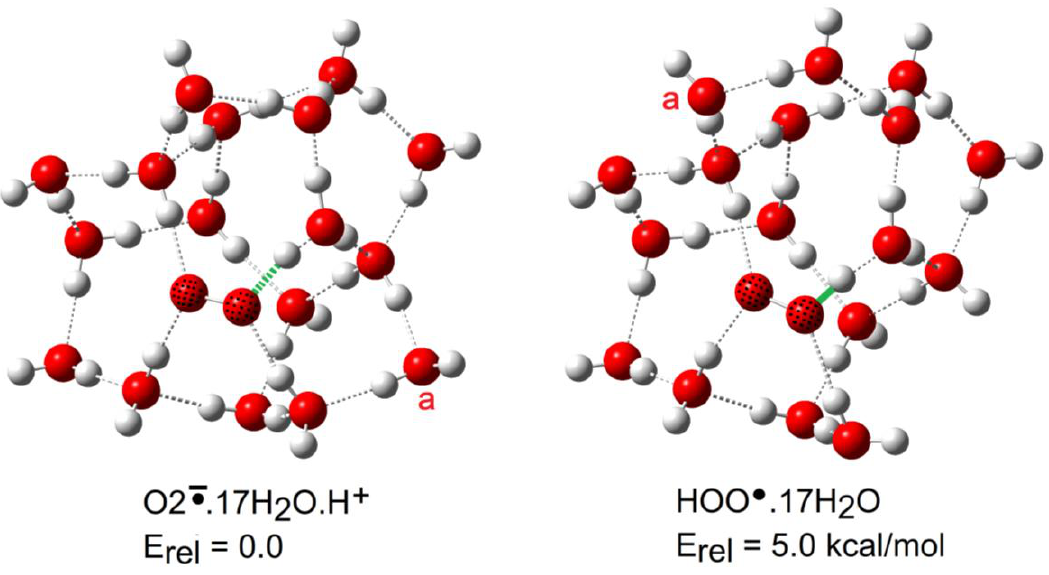
Figure 8. Ionized (left) and un-ionized (right) clusters of the hydroperoxyl radical ( 5H ) with 17 H 2 O molecules. [Bond to departing H + highlighted in green.].